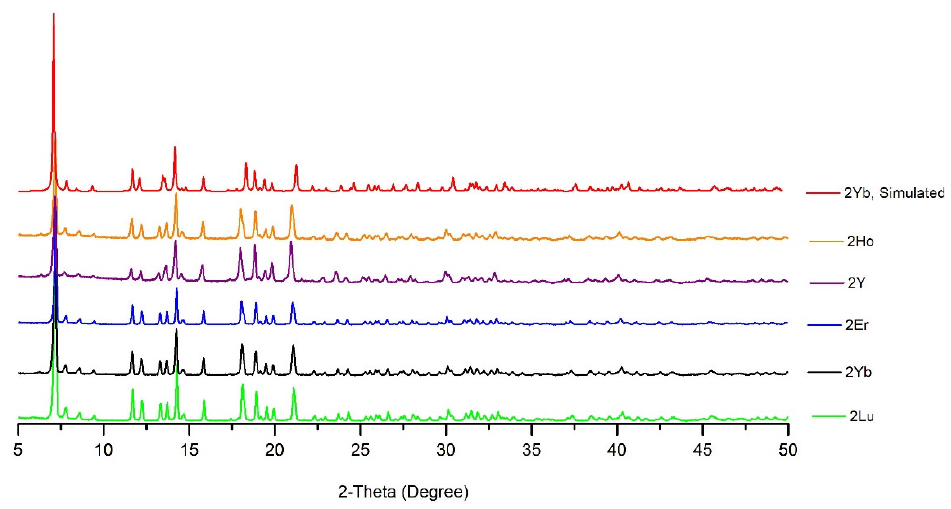
Figure 2. PXRD traces of the [NaRE(3fur) 4 ] n 2RE series compared to the simulated pattern of [NaYb(3fur) 4 ] n ( 2Yb ).